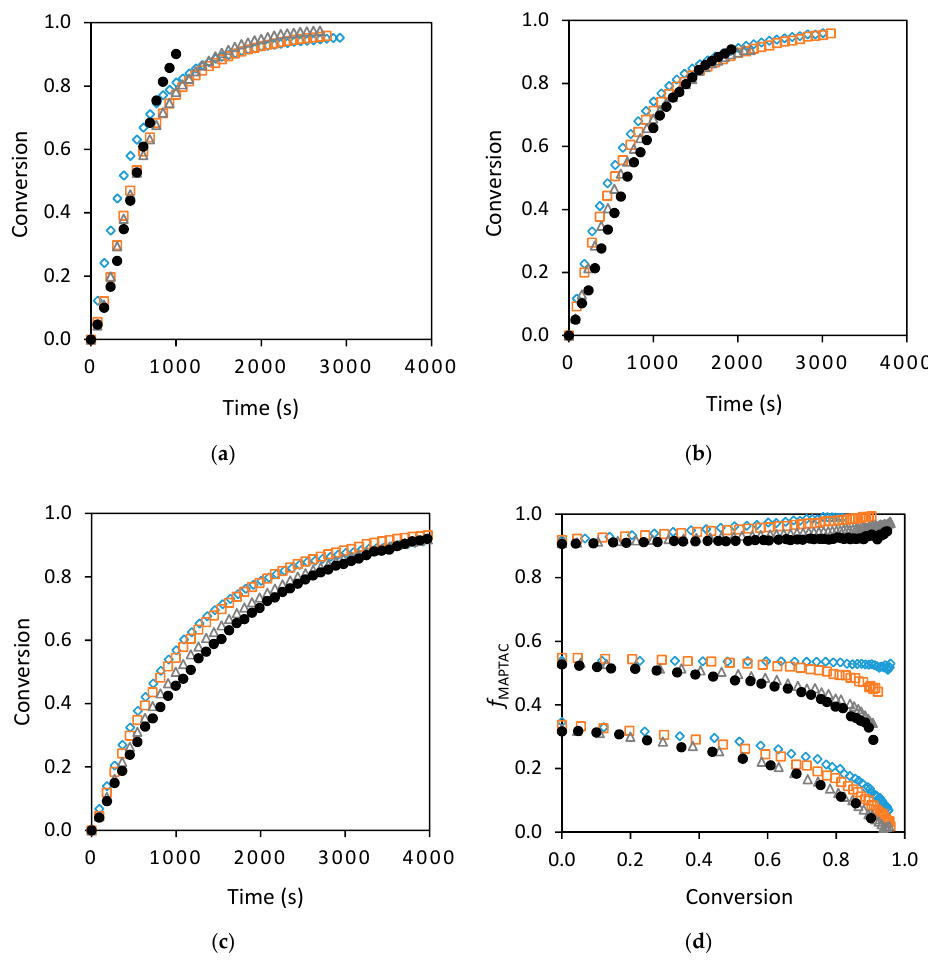
Figure 4. Overall monomer conversion profiles for AA-MAPTAC copolymerization with f MAPTAC,0 of ( a ) 0.3 ( b ) 0.5 and ( c ) 0.9 at 50 ◦ C and 0.80 wt% V-50 with varying w mon,0 of 0.05( ♦ ), 0.10( (cid:3) ), 0.20( ∆ ), 0.40( • ). The corresponding changes in comonomer composition are shown in ( d ) as a function of overall monomer